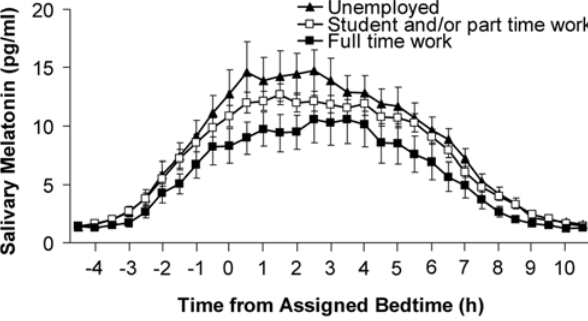
Figure 4. The mean melatonin profiles of the unemployed (n=35), students and/or part-time workers (n=116) and full- time workers (n=19). The profiles are plotted with reference to assigned bedtime. Error bars represent